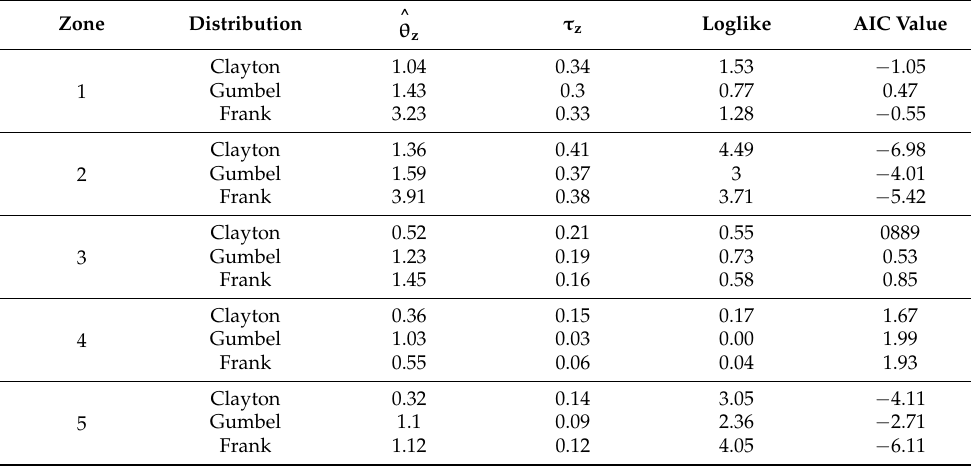
Table 15. Parameter estimation results and AIC values in Cluster Type I